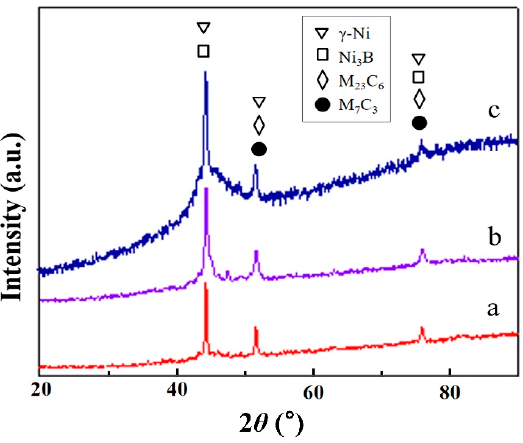
Figure 2. XRD patterns of (a) raw NiCrBSi powder, and (b) post heat-treated and (c) plasma sprayed NiCrBSi coating.